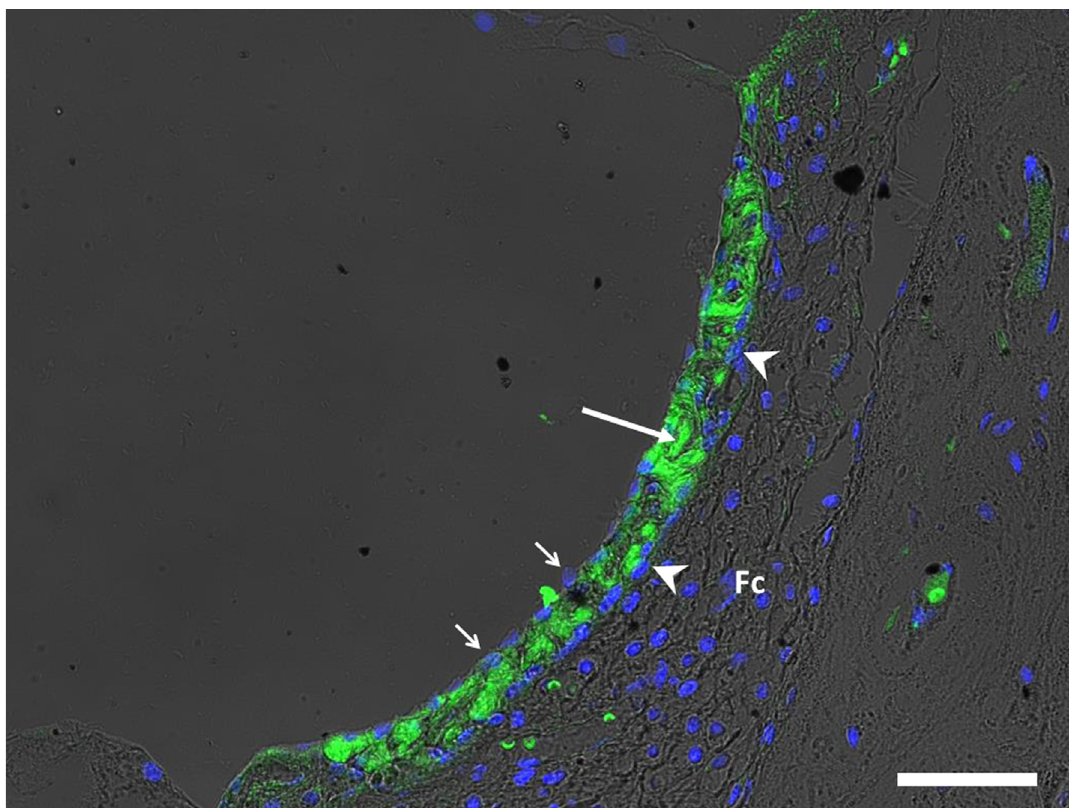
Fig 3. Image showing intense CB 2 immunolabeling in cellular types of the stria vascularis (SV). Intermediate cells are indicated by long arrow. Marginal cells (short arrows); basal cells (arrowheads) might show labeling at some points. Fibrocytes of the spiral ligament (Fc) do not show expression of CB 2 receptors. (Scale bar = 30 μ